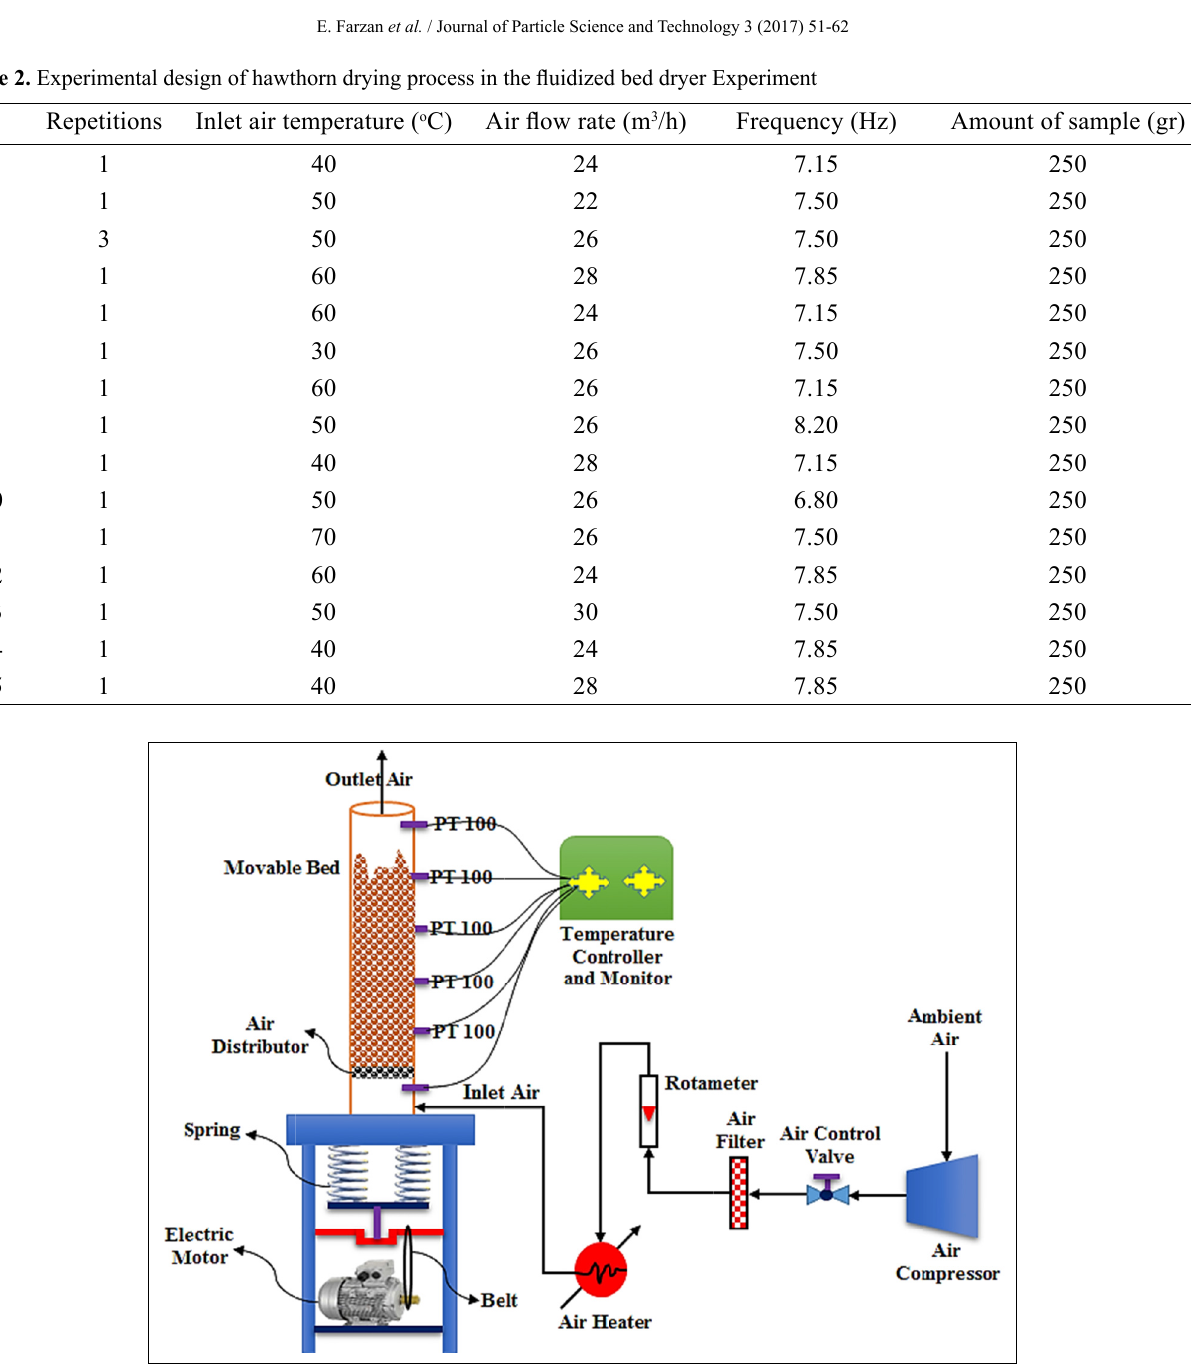
Fig. 2. Schematic diagram of the pilot plant vibro-fluidized bed